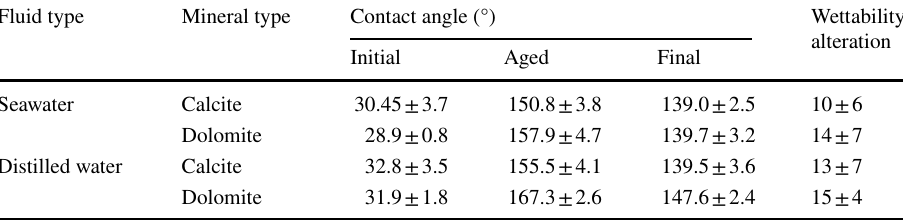
Table 1 Contact angle measurement results for control cases; at 30 °C seawater and distilled water have an insignificant effect on the wettability of calcite and dolomite